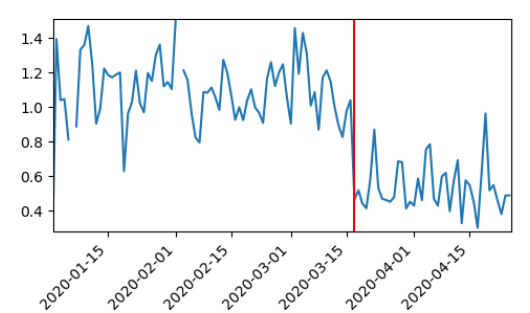
Figure 16. Aggregated occupancy ratio R agg between 2020-01-01 and 2020-04-25, estimated with the C/SimpleT method, adjusted for weekly patterns and summer time. Red line: start of COVID-19 containment measures.